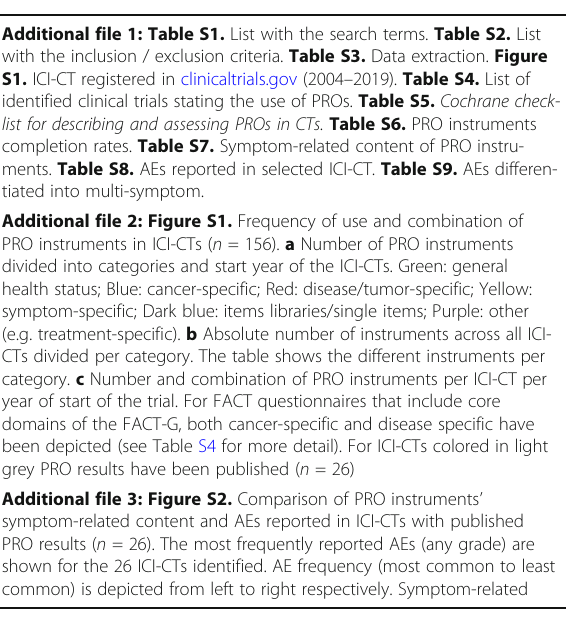
list for describing and assessing PROs in CTs. Table S6. PRO instruments completion rates. Table S7. Symptom-related content of PRO